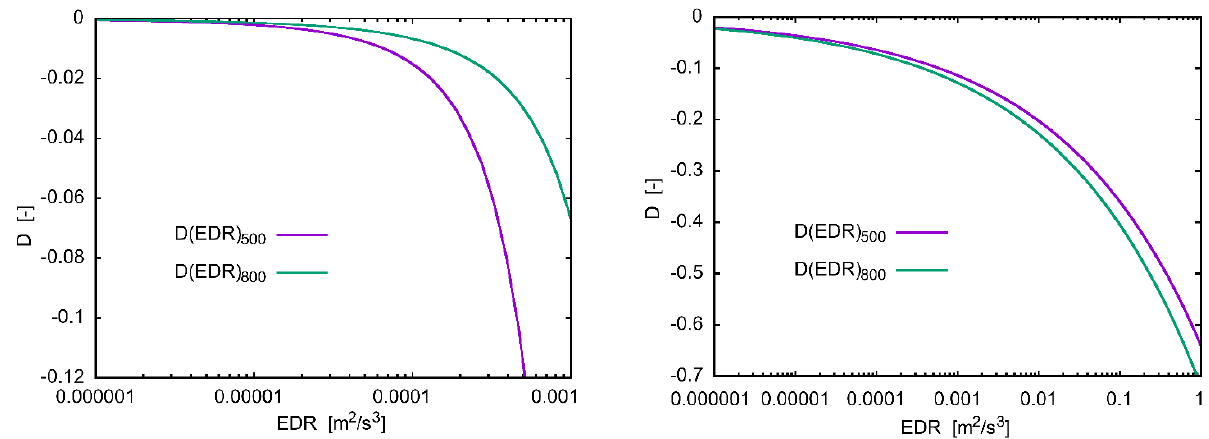
Figure 4. Parameter D vs. eddy dissipation rate (EDR), for t = 100 s, wing span b = 79.75 m, and Γ 0 = 500 and 800 m 2 /s, from ( left ) Equation (27) and ( right ) Equation (28).